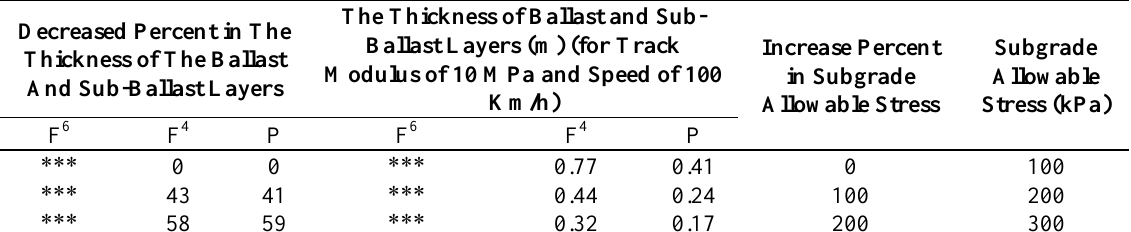
Table 3. Effect of sub grade allowable stress variation on the ballast and sub-ballast layers thickness (sleeper spacing 600mm, UIC 60 rail section). The Thickness of Ballast and Sub- Decreased Percent in The Ballast Layers (m) (for Track Subgrade Increase Percent Thickness of The Ballast Modulus of 10 MPa and Speed of 100 Allowable in Subgrade And Sub-Ballast Km/h) Stress (kPa) Allowable Stress